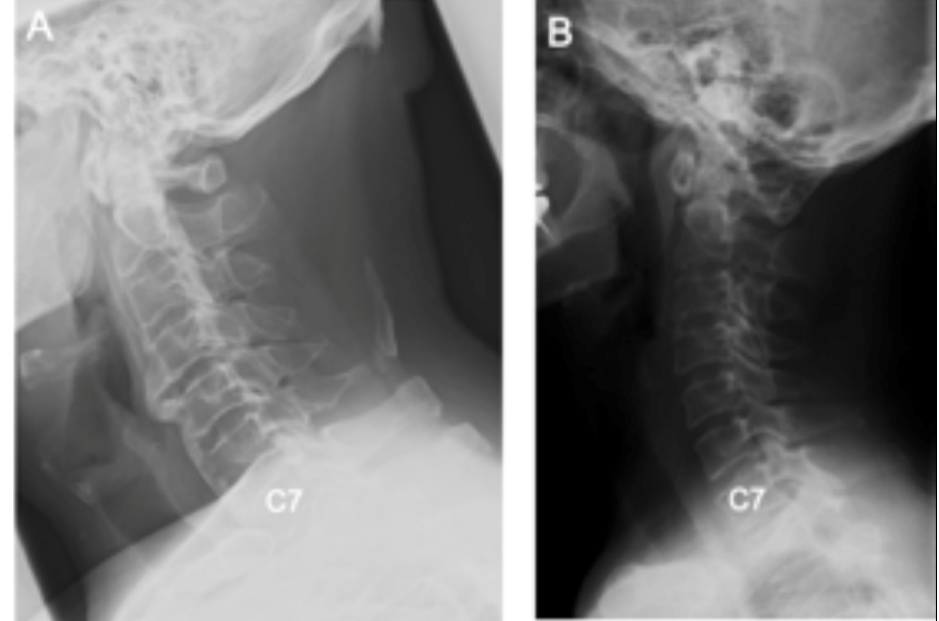
Figure 4. Comparison between invisible and visible T1 slopes of patients. ( A ) Patient with invisible T1 slope: 62 years old, male, ossification of the posterior longitudinal ligament, C2-7 SVA 58 mm, C2-7 angle 4°. ( B ) Patient with visible T1 slope: 63 years old, female, ossification of the posterior longitudinal ligament, C2-7 SVA 19 mm, C2-7 angle 22°.